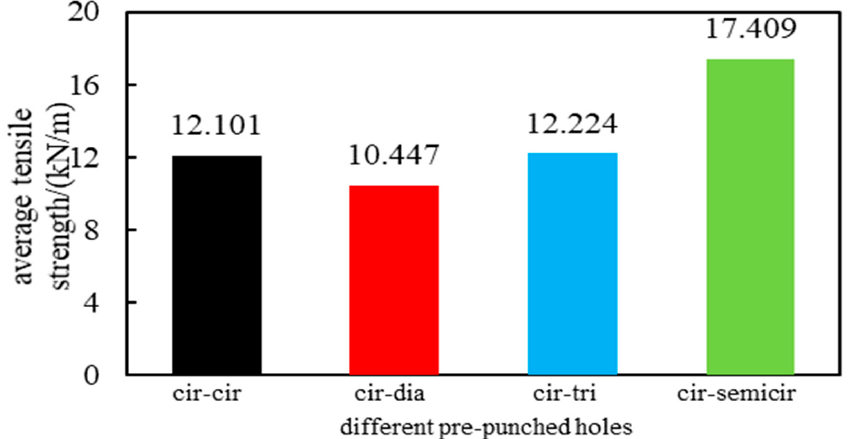
Figure 10. Average tensile strength of performance-optimized multi-axial geogrid with differ- ent